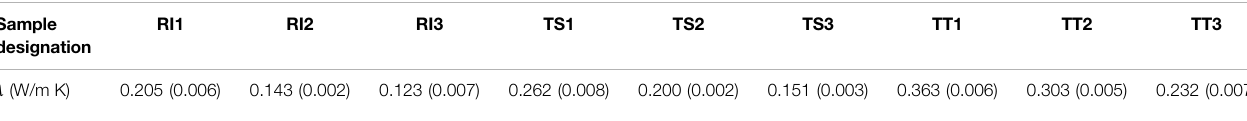
TABLE 4 | Thermal conductivity of the investigated alkali-activated foams cured at 70 ° C (the measured standard deviations are shown in brackets).